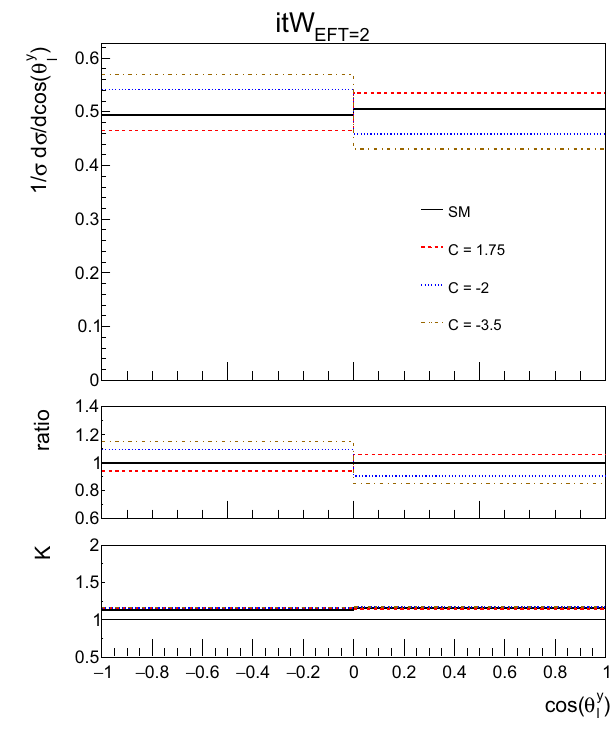
Fig. 17 The NLO distributions of the top polarisation angle for the SM and different values for the imaginary part of O tW . On the left the shape of the distribution can be seen, on the right the same distribution is shown in two bins where the asymmetry is clearly observed. The